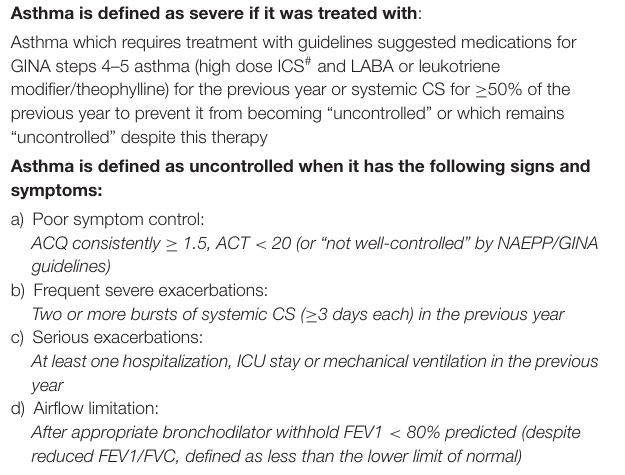
TABLE 2 | Definition of severe asthma (2014 ERS/ATS